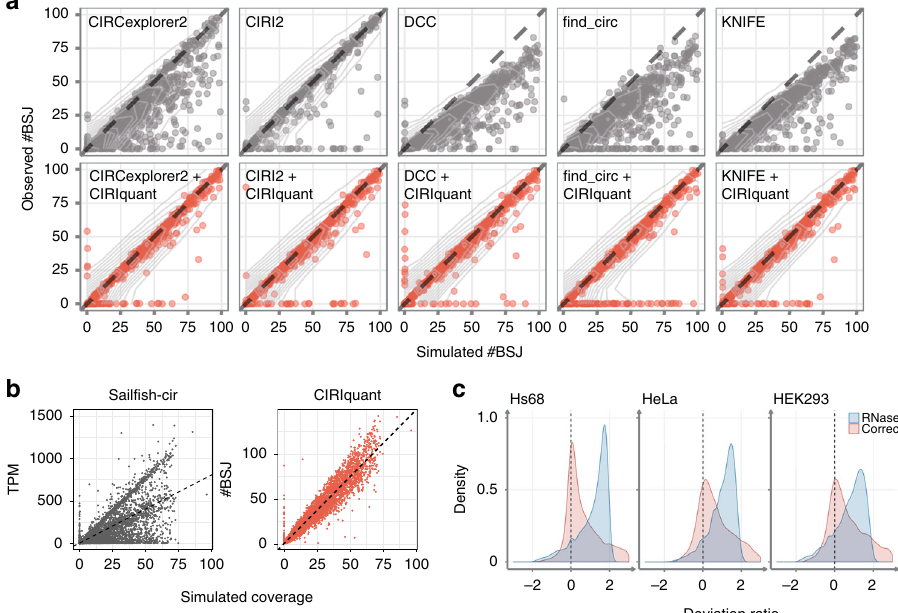
Fig. 3 Performance of CIRIquant on simulated data. a The correlation between simulated and estimated number of BSJ reads. CIRIquant was performed with predicted circRNA junction sites using fi ve different algorithms. The correlation before and after CIRIquant correction are shown separately. Obviously, for all these tools, the inclusion of CIRIquant can signi fi cantly improve circRNA quanti fi cation and remove false-positive predictions. b Comparison of Sail fi sh-cir and CIRIquant on the simulated dataset. TPM of identi fi ed circRNAs was used to evaluate the performance of Sail fi sh-cir. x -axis represents the simulated coverage of each circRNA, and the fi tted linear-regression model was plotted as the dashed line. c Density distribution of deviation ratio of circRNA expression levels between RiboMinus and RiboMinus/RNase R samples. The distribution of deviation ratio derived from uncorrected BSJ reads and expression values after CIRIquant correction are shown in blue and red, respectively. After the correction of RNase R treatment ef fi ciency by CIRIquant, there is no much difference on circRNA quanti fi cation between RiboMinus and RiboMinus/RNase R